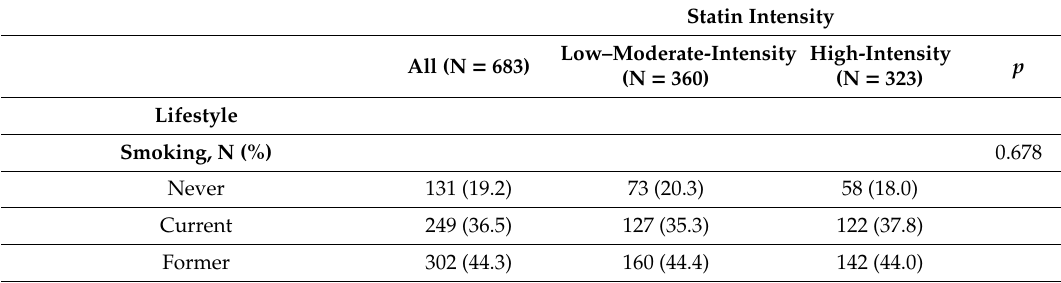
Table 2. Lifestyle characteristics and subclinical atherosclerosis among workers, stratified by statin